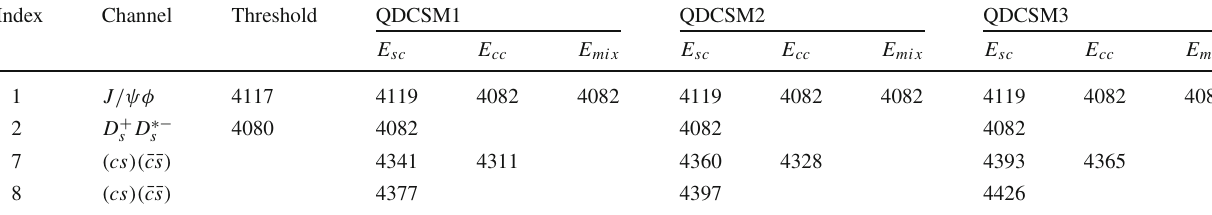
Table 5 The lowest-lying eigenenergies (in MeV) of c ¯ cs ¯ s tetraquarks with J PC = 1 ++